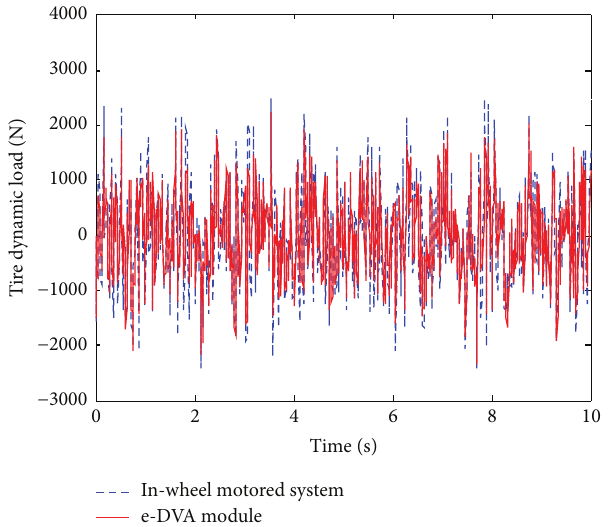
When the motor performs vertical sinusoidal motion with the amplitude of 6.5 mm and angular frequency of 2 𝜋 under vibration, the speed ripple is 12.34 ∘ /s as concluded in ADAMS software. Comparing with wheel speed of 3538 ∘ /s, the speed ripple is much smaller, which has little influence for the common driving and proves the feasibility of application.